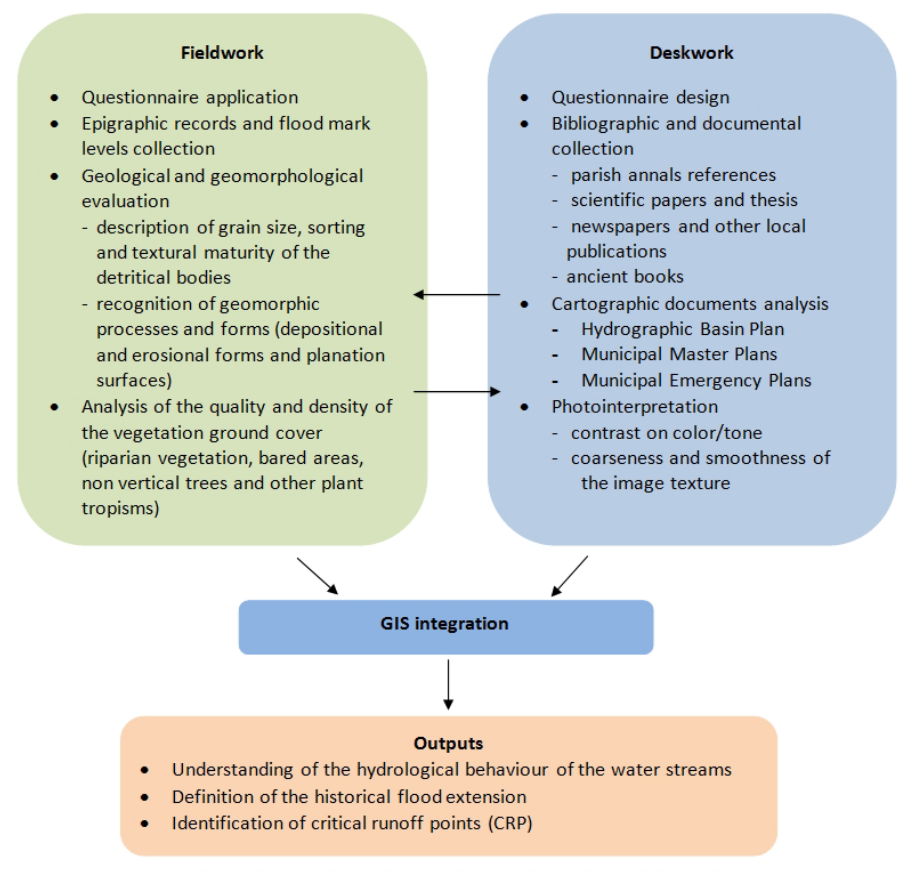
Fig. 3. Methodological approach for historical and hydrogeomorphological reconstitution.